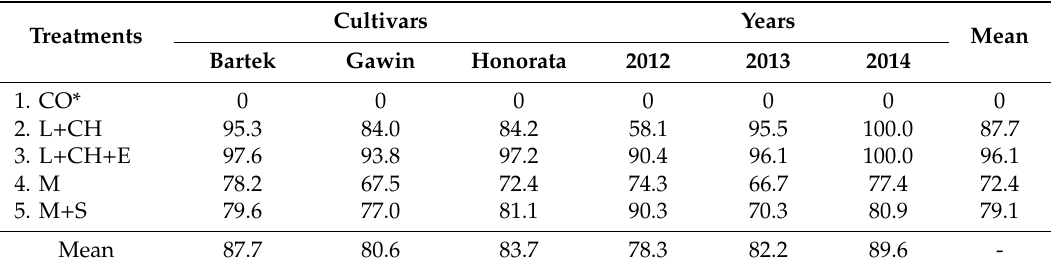
Table 4. Weed reduction (fresh weight of weeds) in relation to control (%).